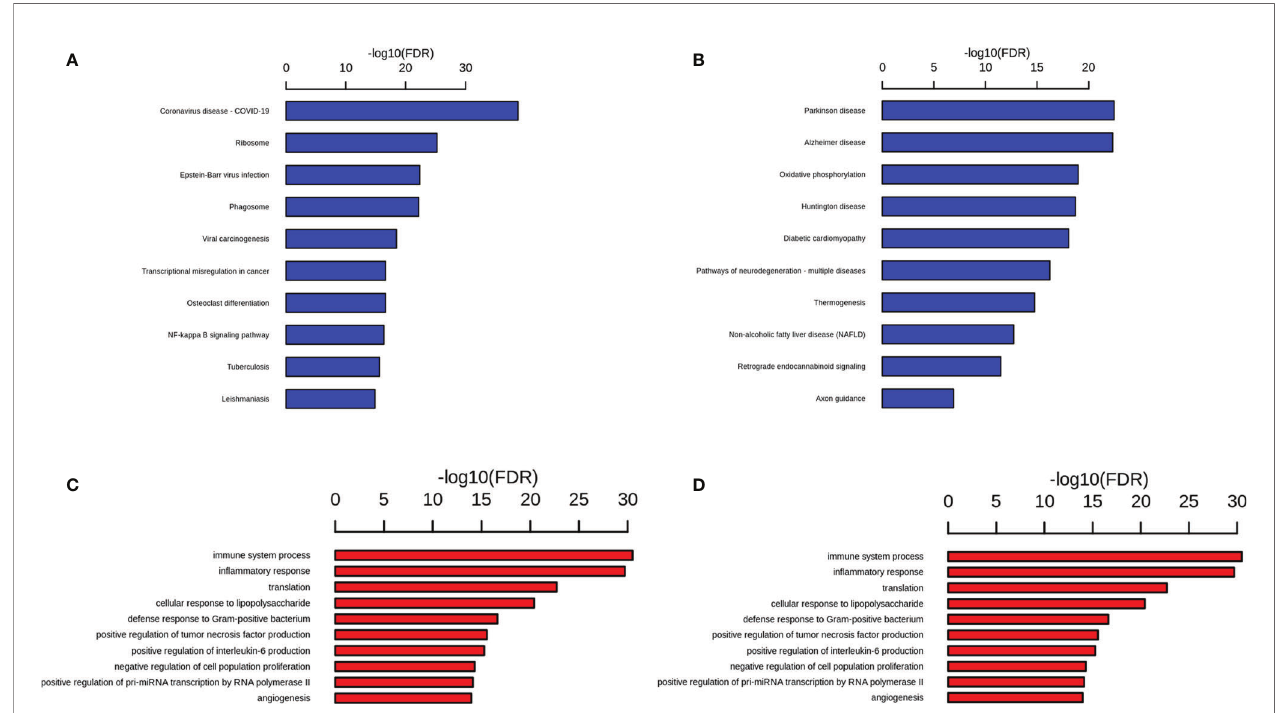
FIGURE 6 | DEGs analysis reveal altered pathways in microglial cells in db/db mice. Representative GO (A) and KEGG (C) terms of upregulated gene in db/db mice microglial cells versus db/m microglial cells and representative GO (B) and KEGG (D) terms of downregulated gene in db/db mice microglial cells versus db/m microglial cells. Signi fi cance is indicated as a P value calculated using the Fisher exact test ( P < 0.05) and expressed as -log 10 ( P